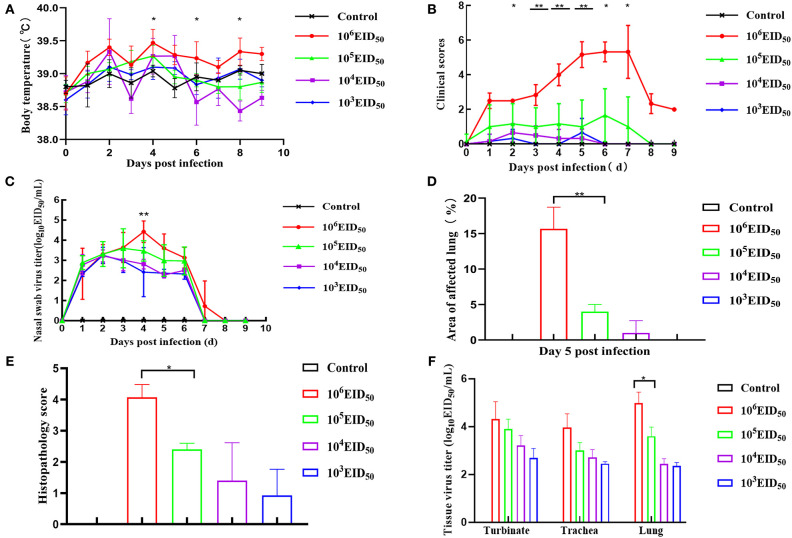
Clinical symptoms. Dogs were inoculated with 106, 105, 104, and 103 EID50 (n = 8) of GD14 virus or PBS (n = 5) as control. Nasal turbinate, tracheal, and lung tissues were collected after euthanizing three dogs in every group at 5 dpi. (A) Body temperature was recorded at days 0–10 dpi; (B) after infection with H3N2 CIV, days 0–10 clinical scores were recorded based on previous criteria (15); (C) nasal swabs were determined by EID50 assay. **P < 0.01 indicates that at 4 dpi, the nasal swab virus titer of the 106 EID50 group was extremely different from that in the 105 EID50 group; (D) lung lesion score; (E) histopathology score. **P < 0.01 indicates that at 5 dpi, the lung lesion scores of 106 EID50 were extremely significantly higher than that of 103 EID50. (F) Tissue virus titer. An EID50 assay was conducted to evaluate the virus titers in the turbinate, tracheal, and lung tissues at 5 dpi (n = 5 per group). Error bars represent the standard errors of the mean; p-values using Student's t-test are indicated.